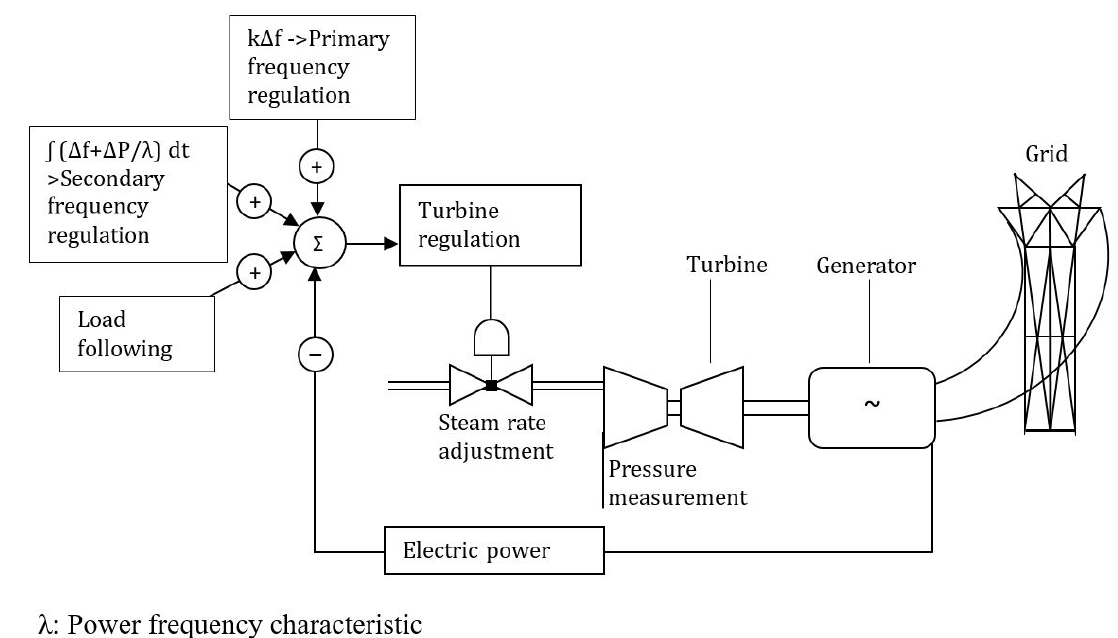
Figure 2. Frequency control in a power plant. Table 3. Design Philosophy for Flexible Operation in German Light Water